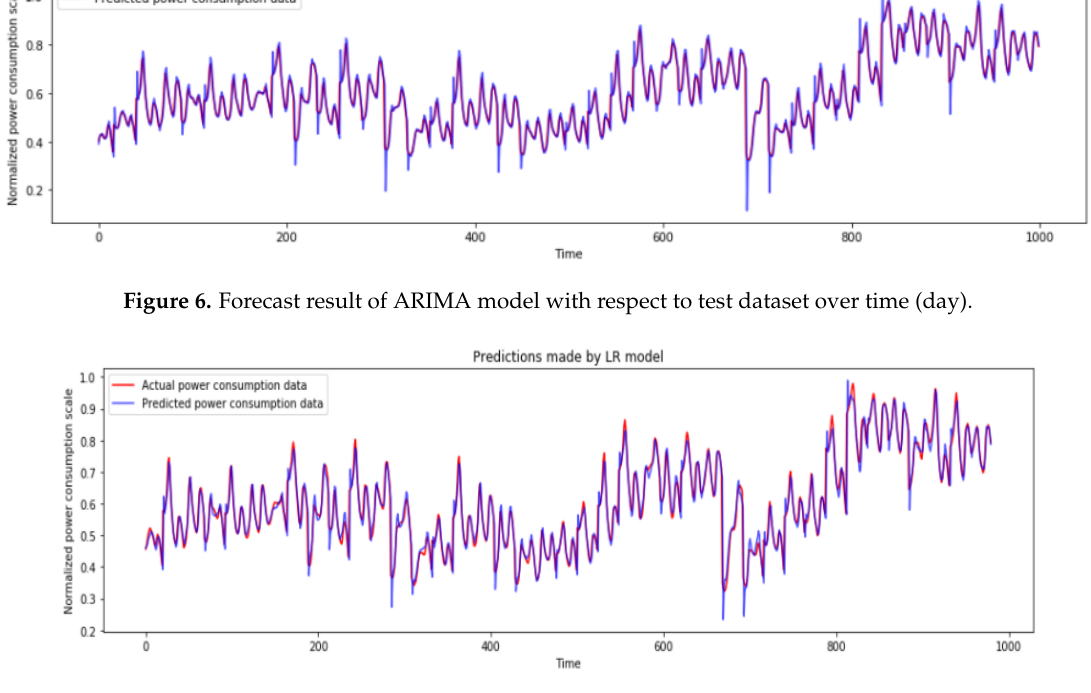
Figure 7. Forecast result of linear regression with respect to test dataset over time (day).